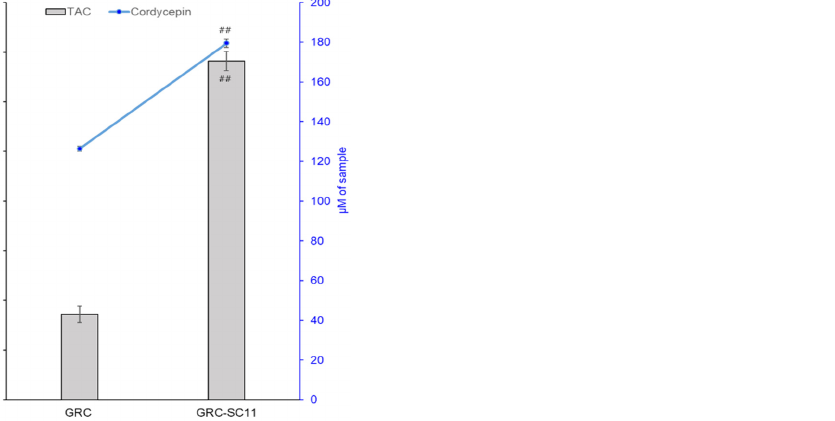
Figure 1. Total antioxidant capacity (TAC) and cordycepin content of C. militaris grown on germinated R. nulubilis (GRC) and GRC fermented by P. pentosaceus isolated from the salted small octopus (SC11) (GRC-SC11). The experiments were repeated three times and results are presented as mean ± SD. TAC was expressed as mg ascorbic acid equivalent (mgAAE). Results were considered significant at the p value of ## p < 0.01. Data comparisons between the two groups were analyzed using the Student’s t -test.